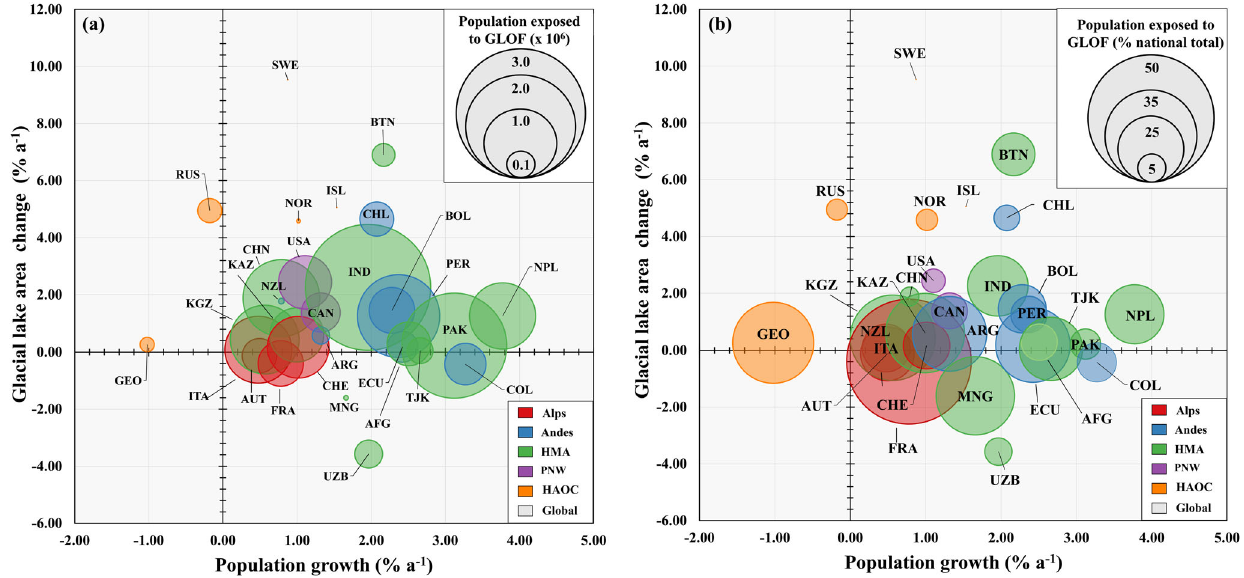
Fig. 4 | Rate of change in glacial lake area and total population. Rates of population change between 1990 and 2020 and glacial lake area change between 1990 and 2018 as a absolute population exposed to GLOFs and b percentage of nationalpopulationexposedtoGLOFsineachcountry.Countriesarecolourcoded